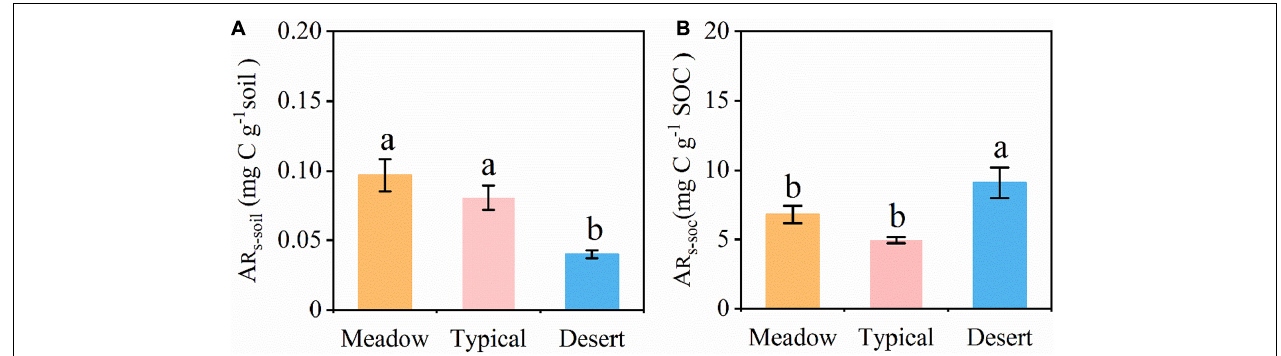
FIGURE 3 | (A) Accumulation of released soil CO 2 ( A Rs − soil ) for 48 h after a simulated precipitation event. (B) Accumulation of released SOC CO 2 ( A Rs − SOC ) for 48 h after a simulated precipitation event. A Rs − soil and A Rs − SOC were calculated based on the soil and soil organic C, respectively. A Rs − soil , accumulative emission of CO 2 relative to soil mass; A Rs − SOC , accumulative emission of CO 2 relative to SOC. Error bars represent SE (Meadow and Desert, n = 3; Typical, n = 4). Different lowercase letters indicate significant differences at P < 0.05.